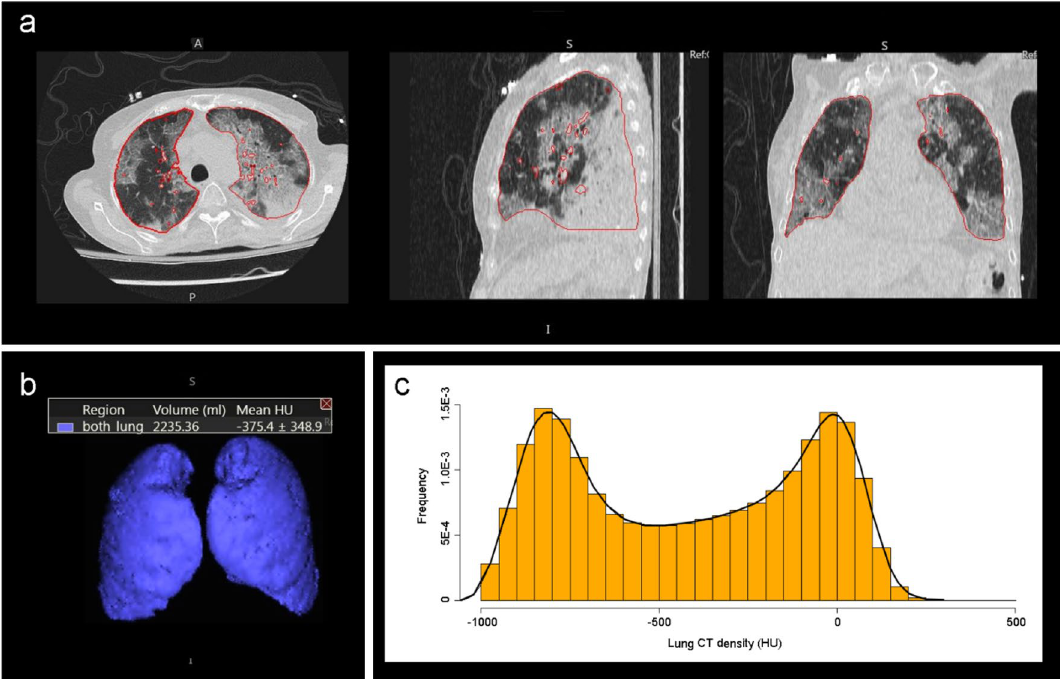
Figure 5. Non-contrast low dose chest CT images in a 62-year-old woman with severe COVID-19 pneumonia. The patient was admitted to ICU, required ventilation, and died in hospital. ( a ) CT images show bilateral extensive ground glass opacities and septal thickening. ( b ) 3D view with volume. ( c ) Histogram of CT density values demonstrates 2 peaks, the first peak at − 800 HU representing normal well aerated lung and the second peak at 0 HU representing the lung consolidations and ground glass opacities. Mean lung density: − 375.4 HU (98th percent.), SD-CT: 348.9 HU (94th perc.), skewness: − 0.02 (7th perc.), kurtosis: 1.53 (0.6th perc.), Q875: 36HU (88th perc.), F1: 0.77 (98th perc.), F2: − 0.33 (9th